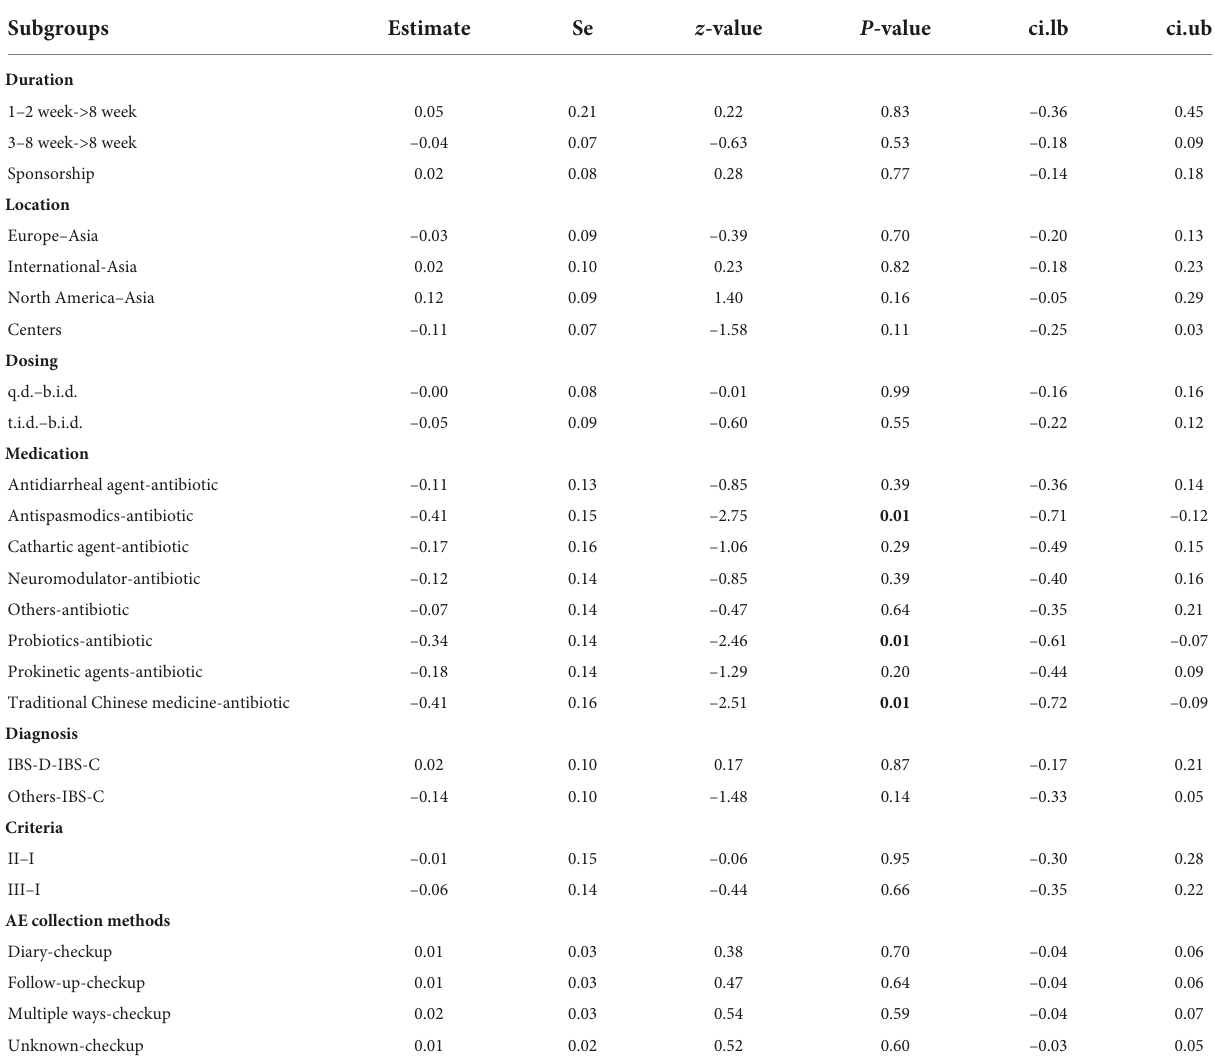
TABLE 3 Moderators of the nocebo